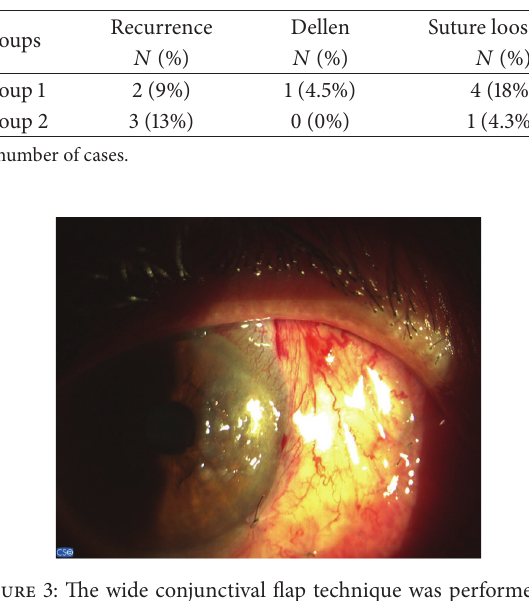
Table 2: Distribution of the complications in groups.